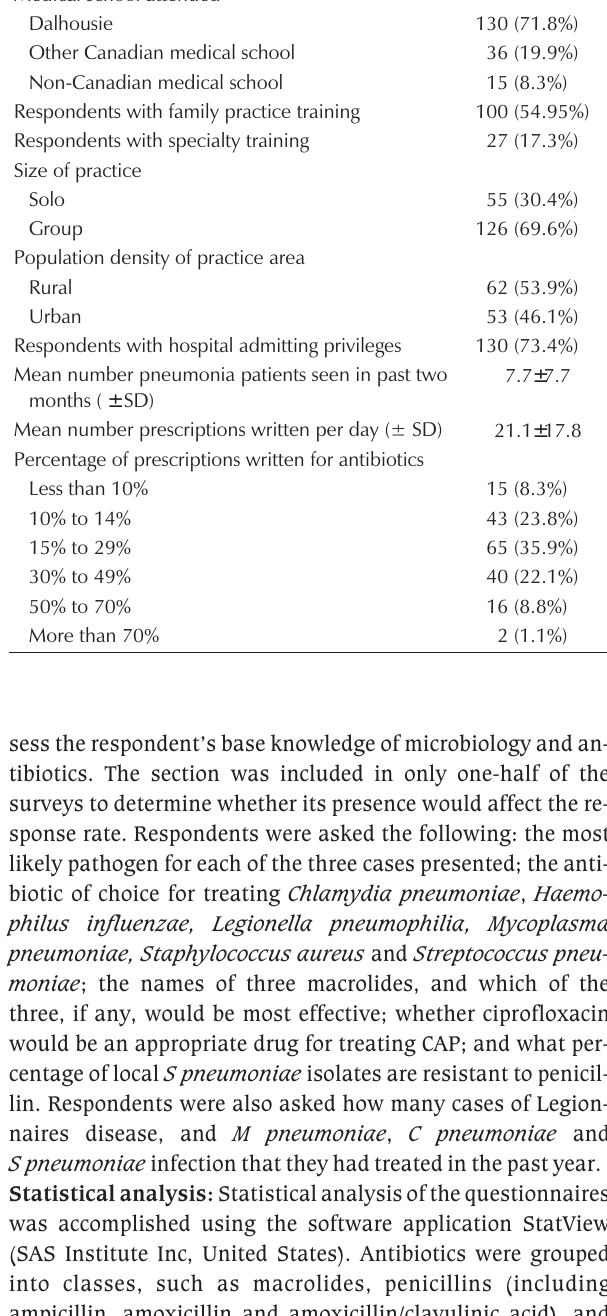
Color profile: Disabled Composite Default